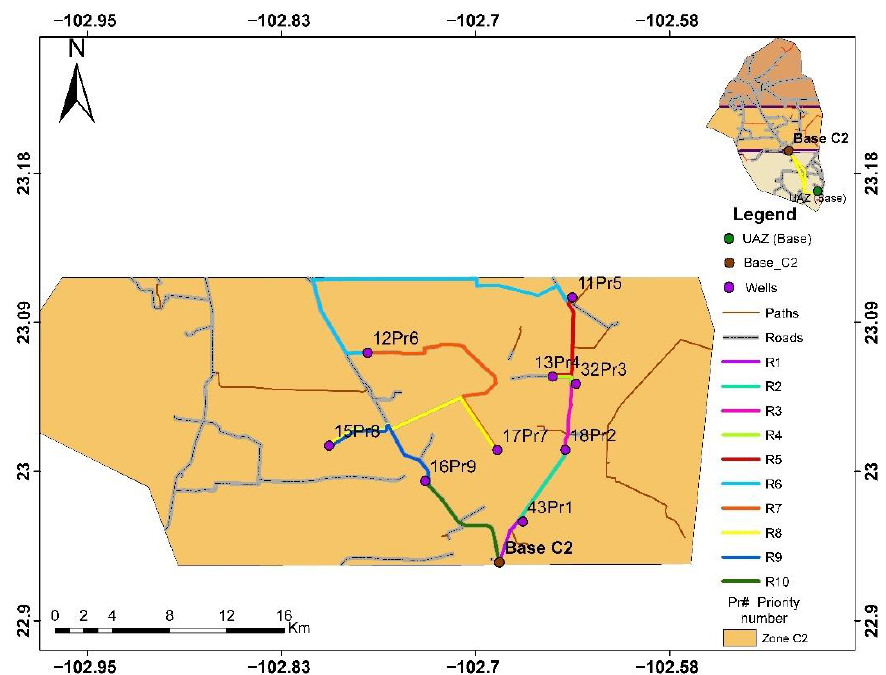
Figure 7. Monitoring wells with their visit priorities for Zone C2; the monitoring route begins and ends at the UAZ (Base).